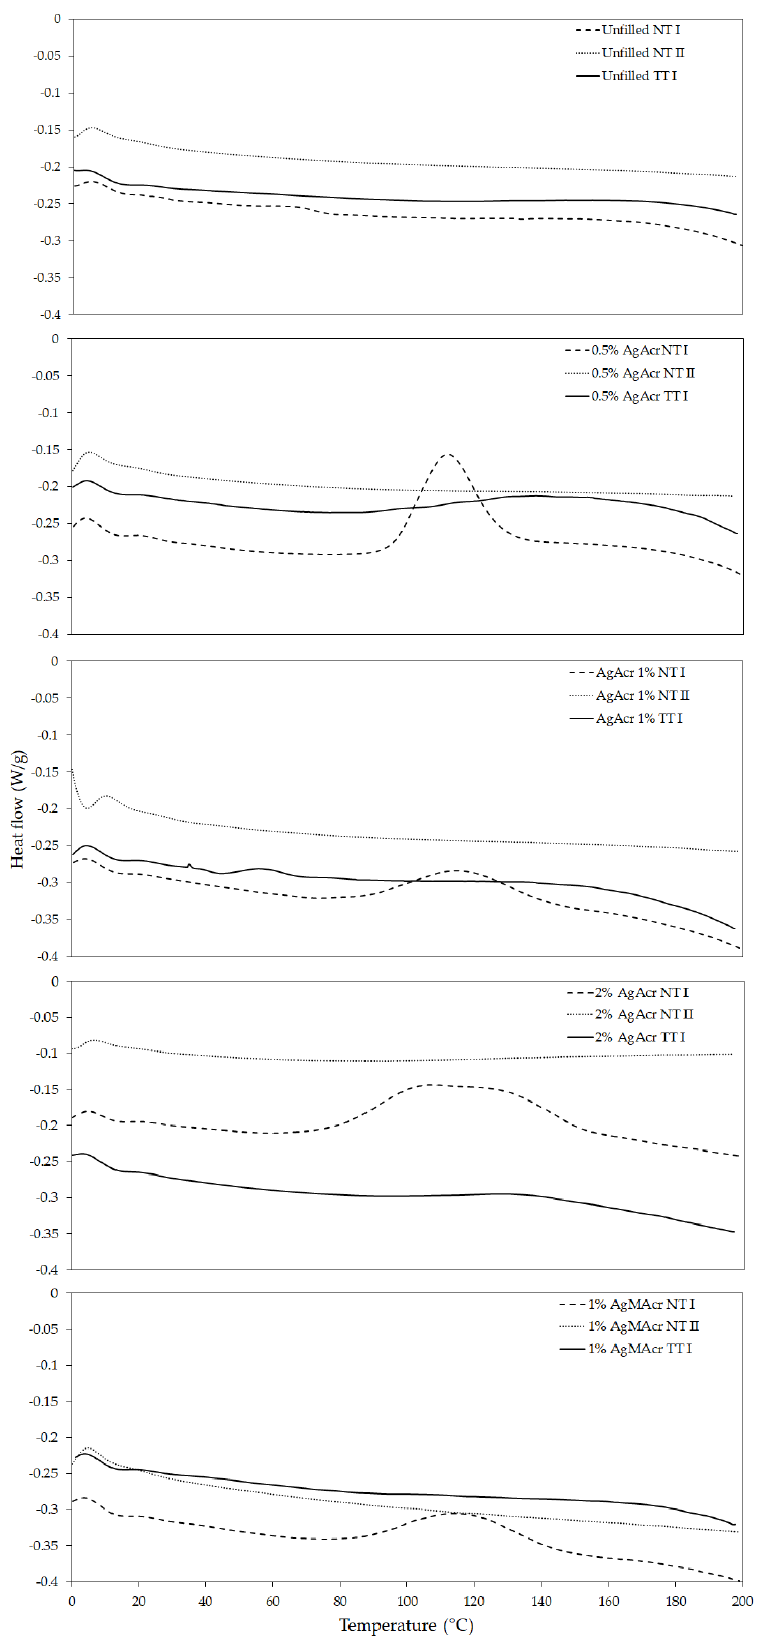
Figure 4. Differential scanning calorimetry (DSC) thermograms (hexo up) of “Unfilled”, “AgAcr x %” and “AgAcr 1%” (TT: after thermal treatment; NT: no thermal treatment; I: first heating scan, II: second heating scan).